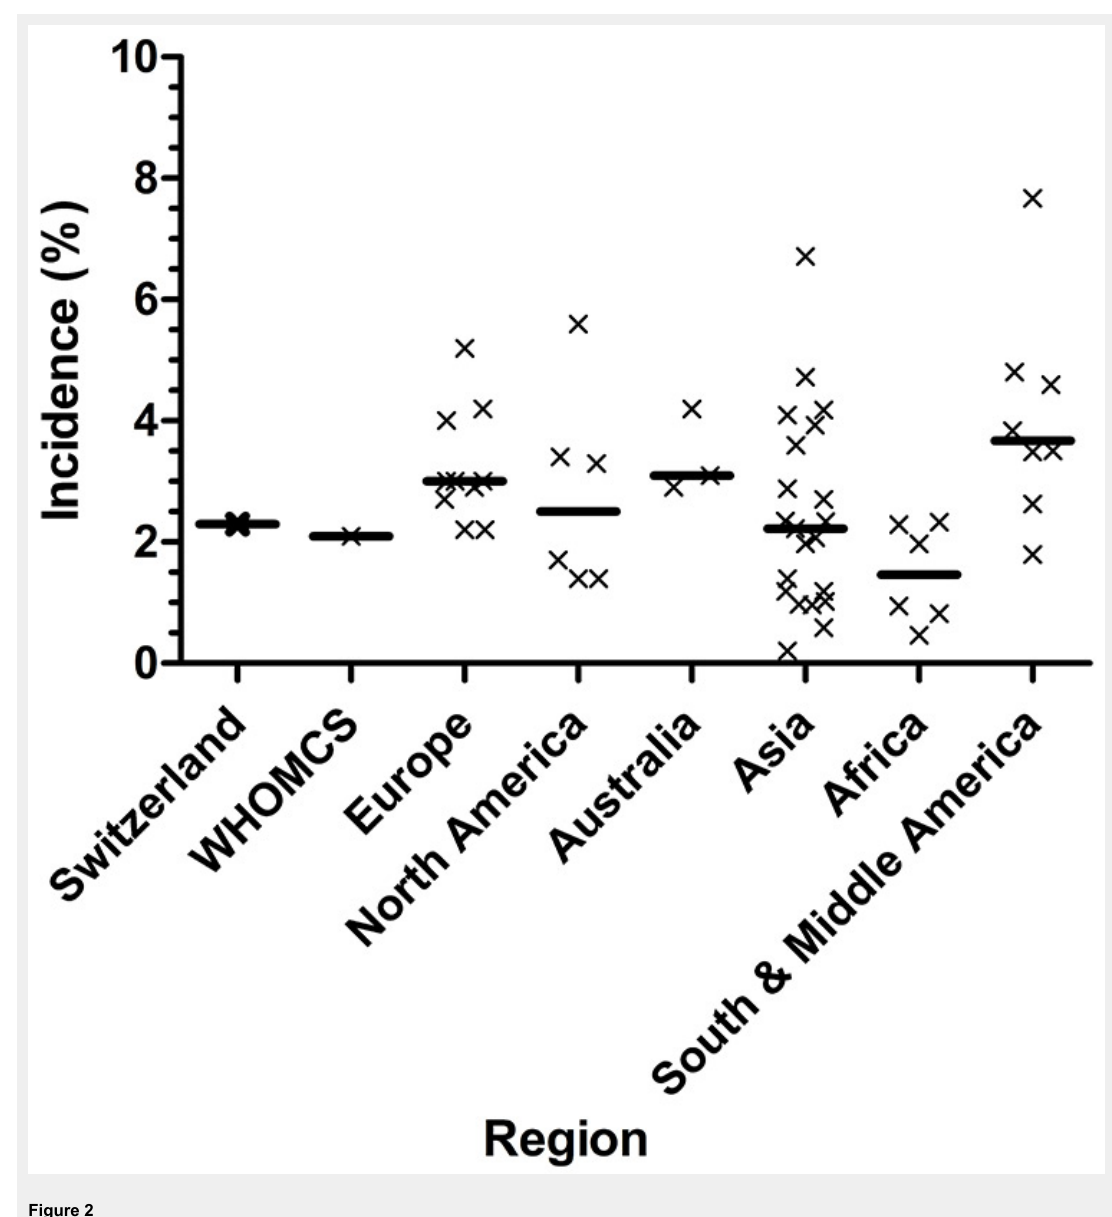
Figure 2 Observed incidence of preeclampsia in the Swiss PRADO study compared with worldwide and regional incidences. X denotes a point incidence observed at a specific period of time in a specific country. A bold horizontal line indicates the median of all observed incidences within a regional group. Data are taken from references [18, 26, 27, 33, 43–57] and are specified in more detail in table 3. Summary data from WHOMCS (World Health Organization Multicountry Survey on Maternal and Newborn Health) originate from reference